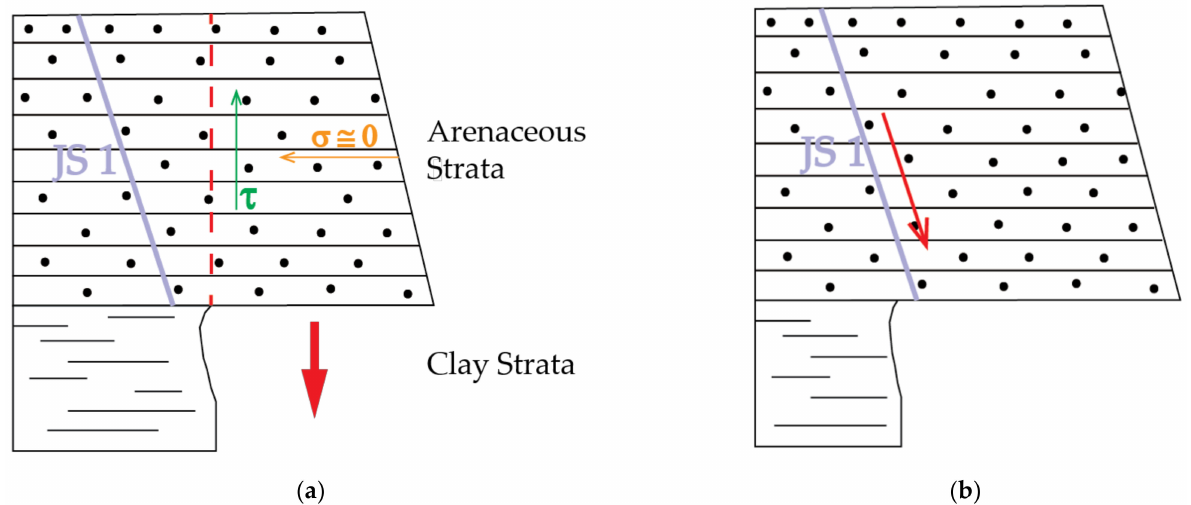
Figure 6. Conceptual model related to the two main triggering mechanisms of rockfall phenomena on the Poggio Baldi rock cliff: ( a ) Breaking of the arenaceous mass due to shear strength ( τ ) exceedance; ( b ) Failures due to planar sliding along the JS 1 discontinuity